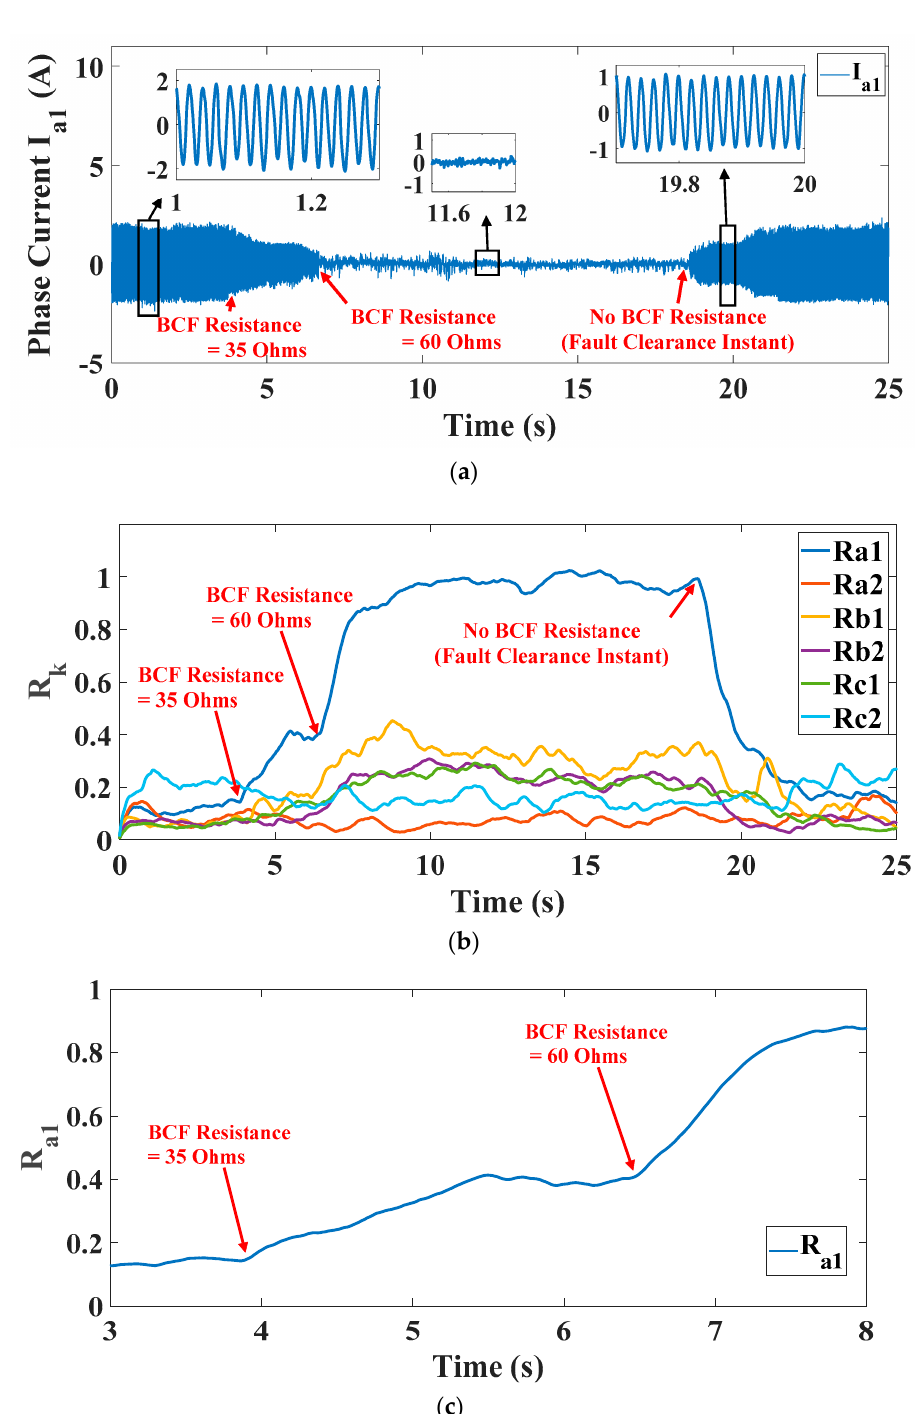
Figure 9. Bad connection test: ( a ) Phase current (a1); ( b ) Fault indices; ( c ) Ra1 (zoom-in view).